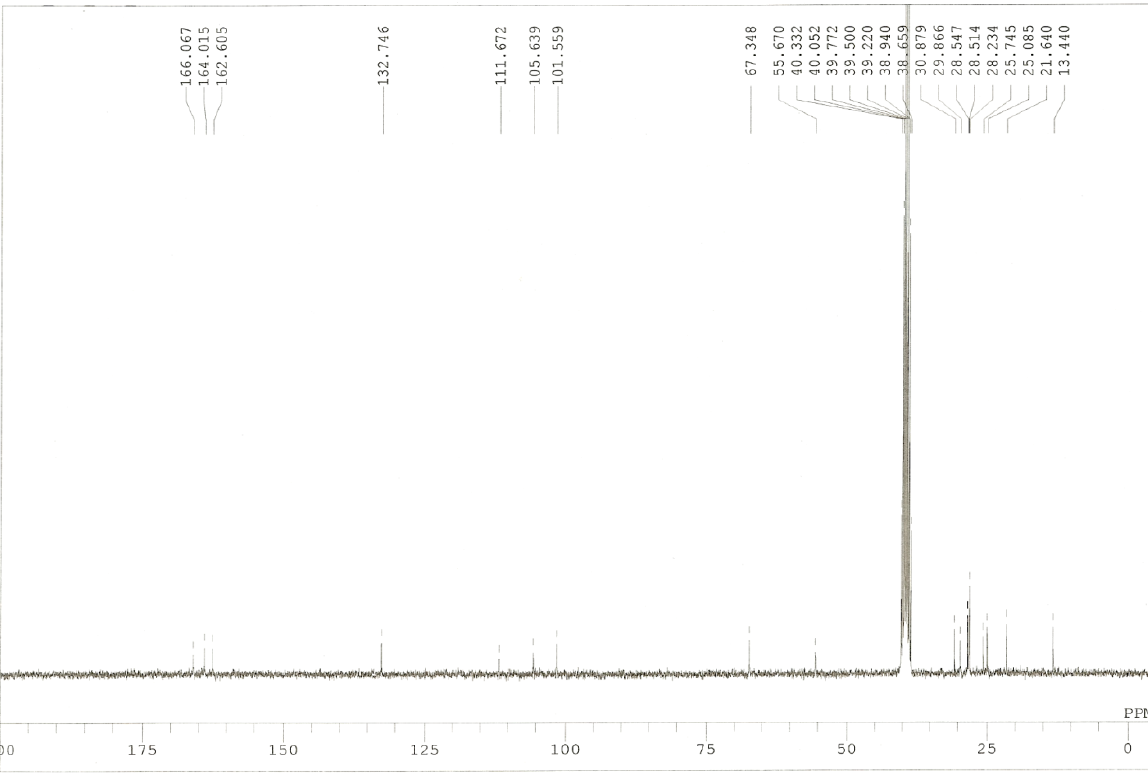
(L 2 H ) (NO ) ](NO ) 2 2 3 3 4 3